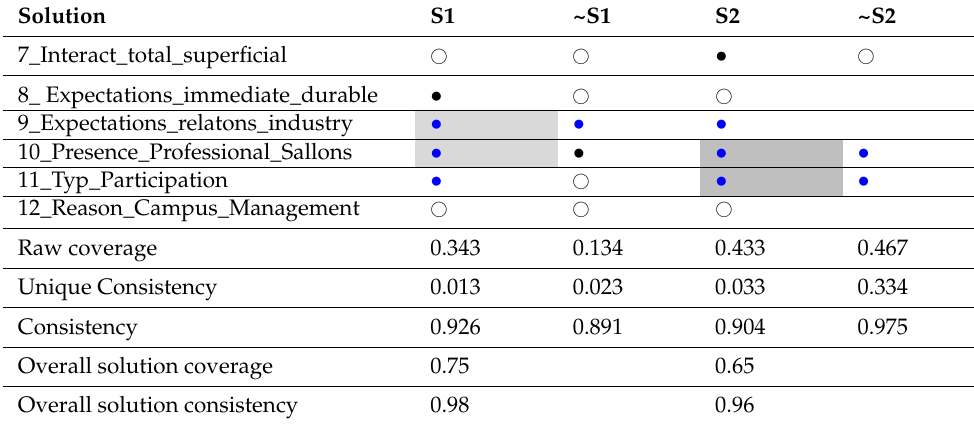
Table A4. Paths to lead to the outcome of relationship